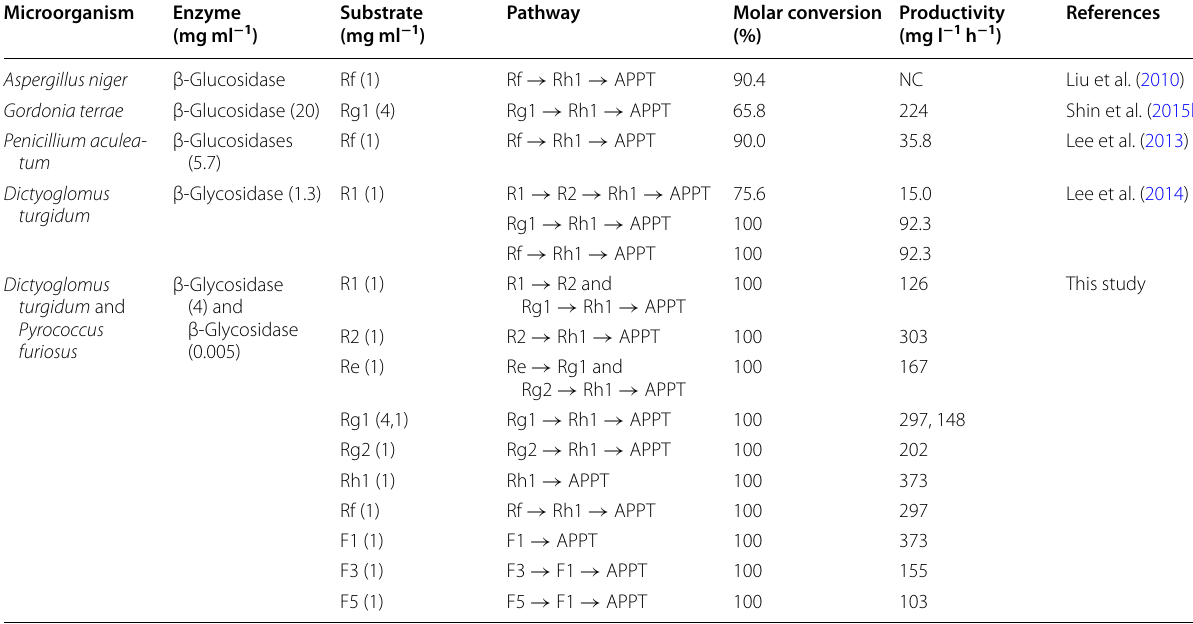
NC not calculated